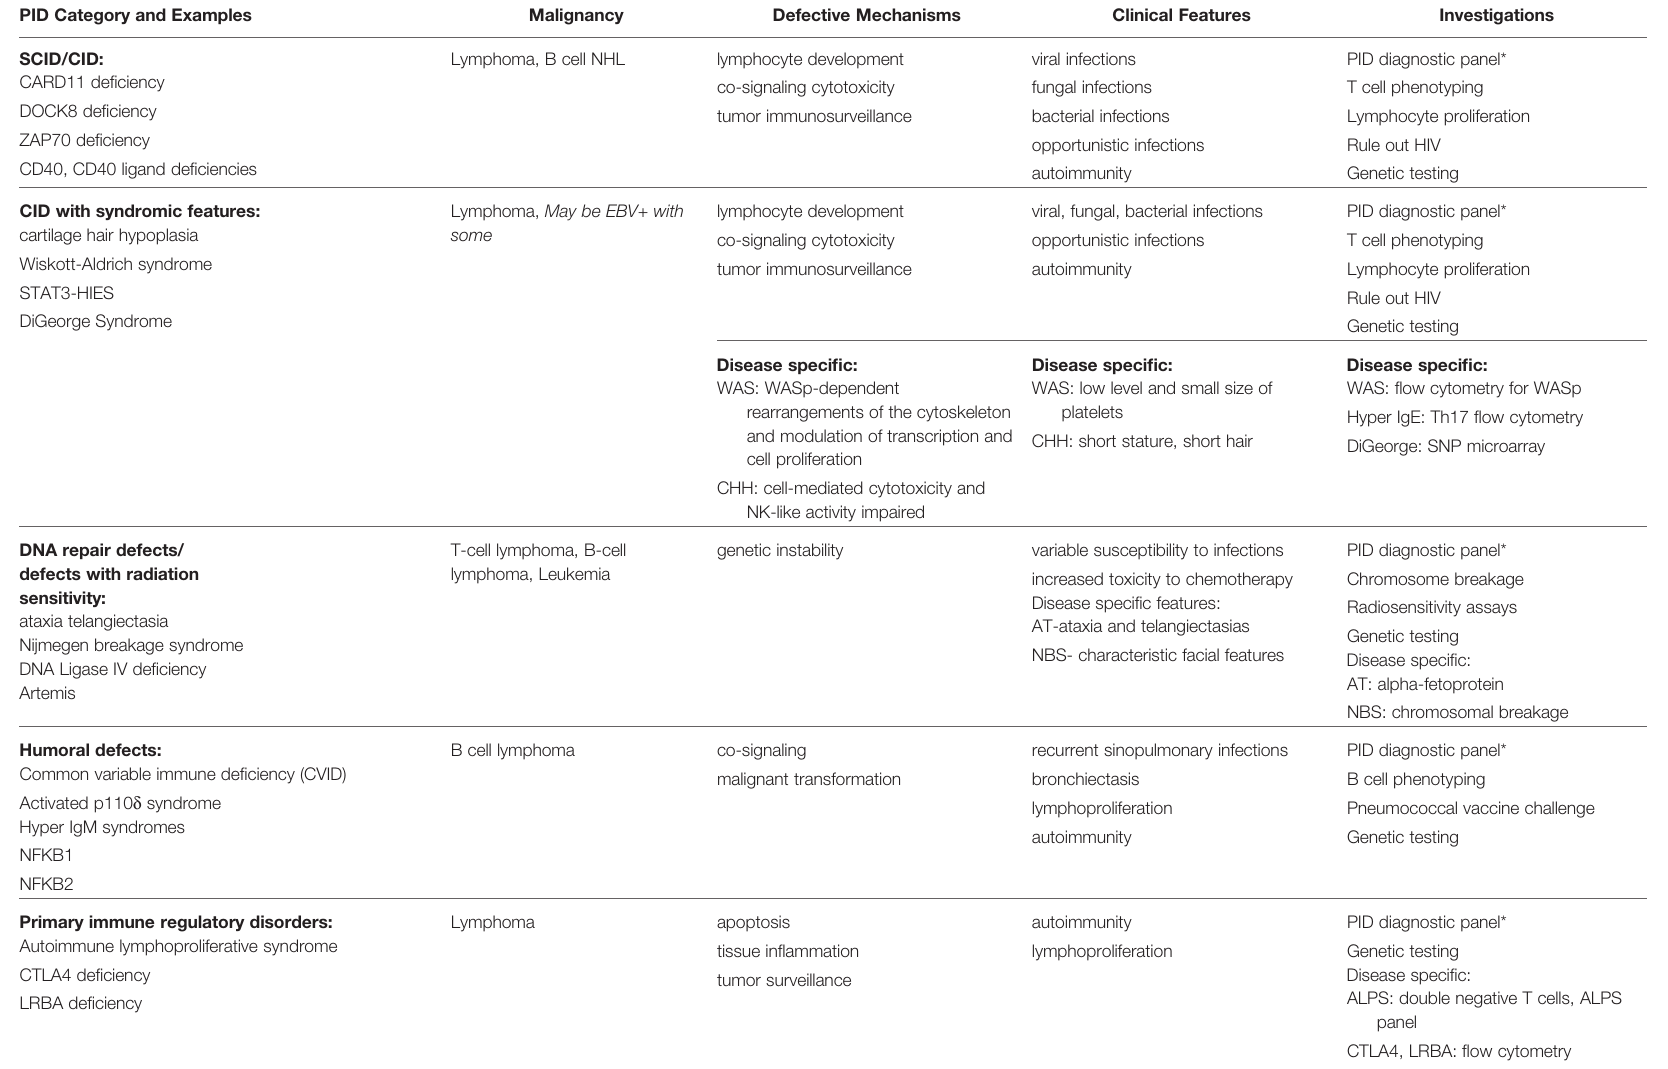
TABLE 1 | Primary immune de fi ciencies and malignancy: pathophysiology, clinical presentation and diagnostic approach (2 –